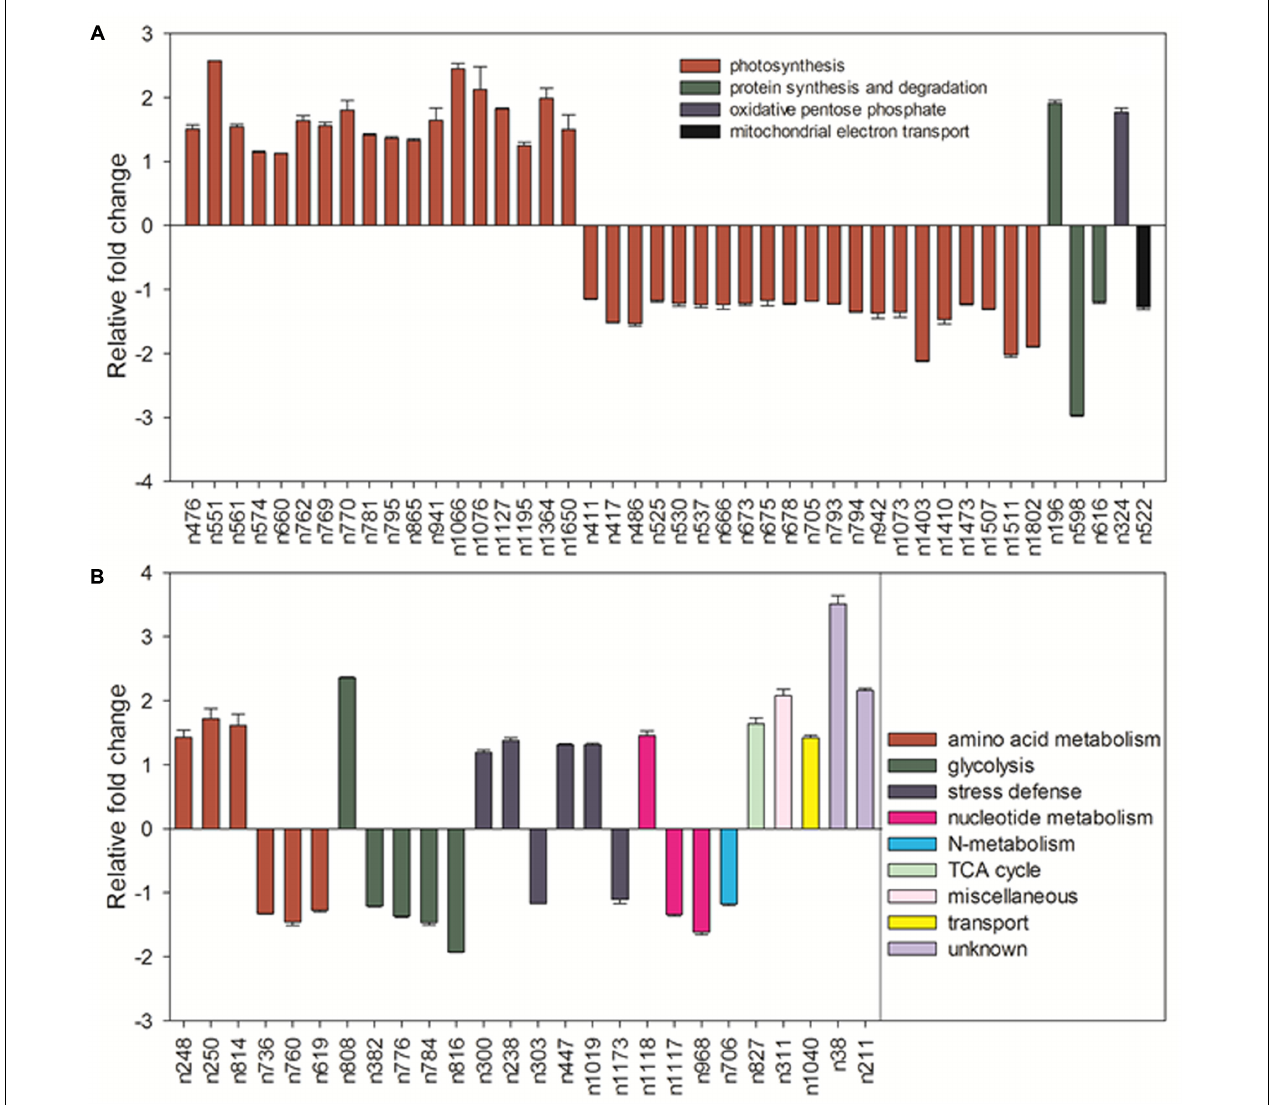
FIGURE 14 | Comparison of protein abundance caused by elevated CO 2 (800 µ mol · mol − 1 ) with ambient CO 2 (400 µ mol · mol − 1 ) under normal temperature control (30 ◦ C). Charts are organized by the functional category of proteins involved in photosynthesis, protein synthesis and degradation, oxidative pentose phosphate and mitochondrial electron transport as shown in (A) as well as amino acid metabolism, glycolysis, stress defense, nucleotide metabolism, N-metabolism, TCA cycle, miscellaneous, transport and unknown proteins as shown in (B) . The values of the mean ± SE represent the relative expression fold change of proteins in response to elevated CO 2 under normal temperature. Labels with ‘n’ in X-axle were same as Table 2